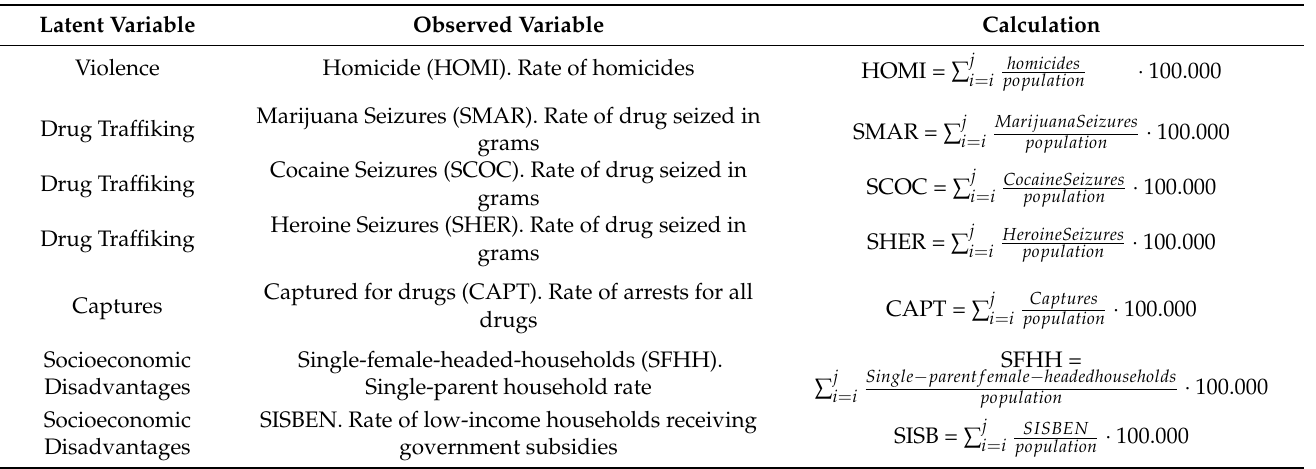
Table 1. Description of the variables